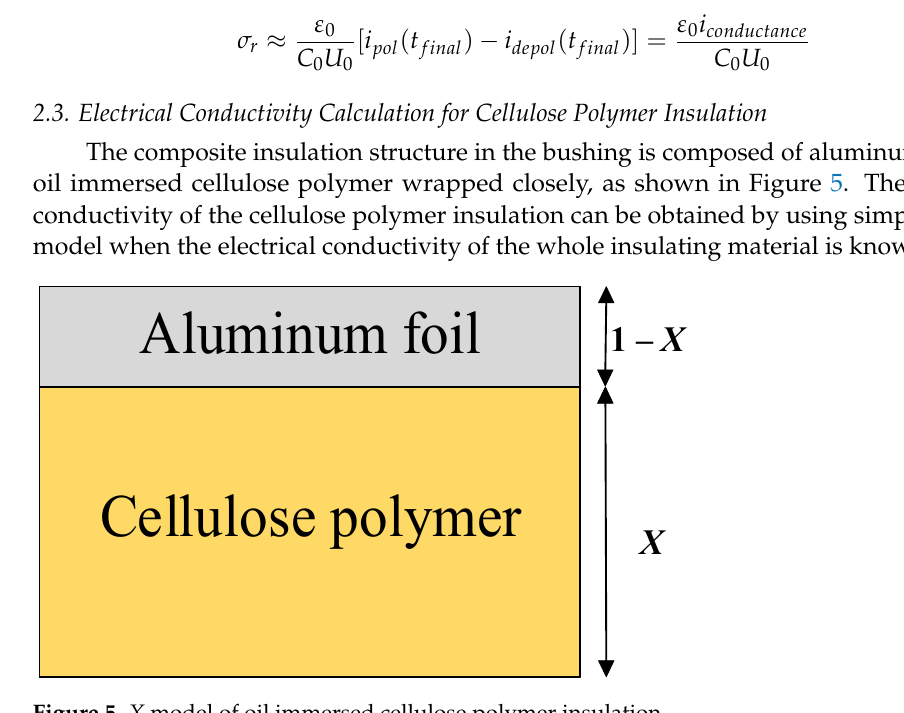
Figure 5. X model of oil immersed cellulose polymer insulation.